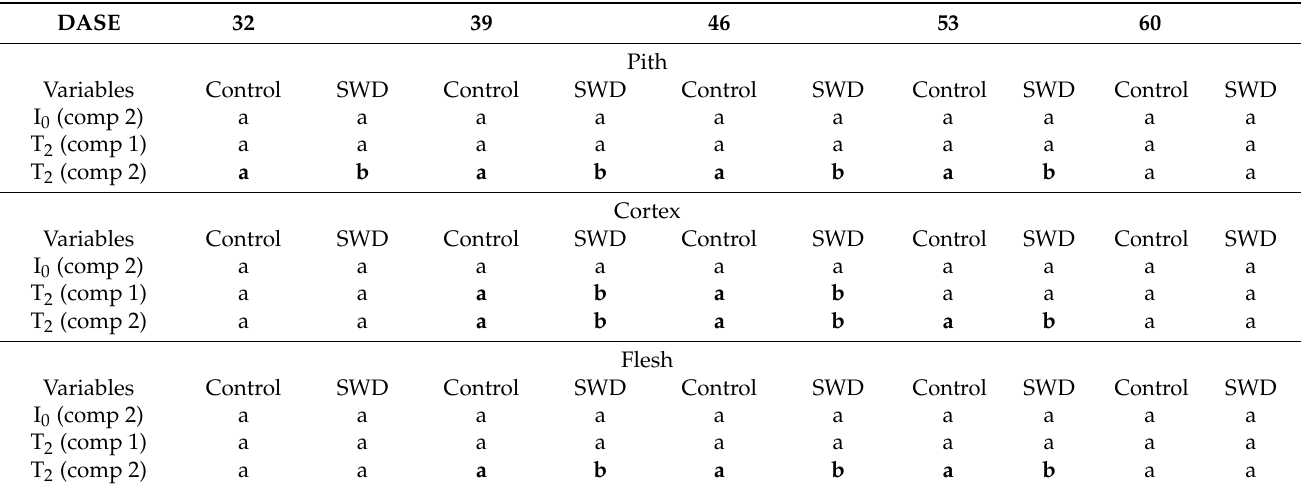
Table 5. Statistical evaluation of the effect of water regime on MRI parameters (Student t-test or Mann–Whitney test; Statgraphics, alpha = 5%). Different letters between Control and SWD conditions for the same DASE indicate a statistically significant difference.